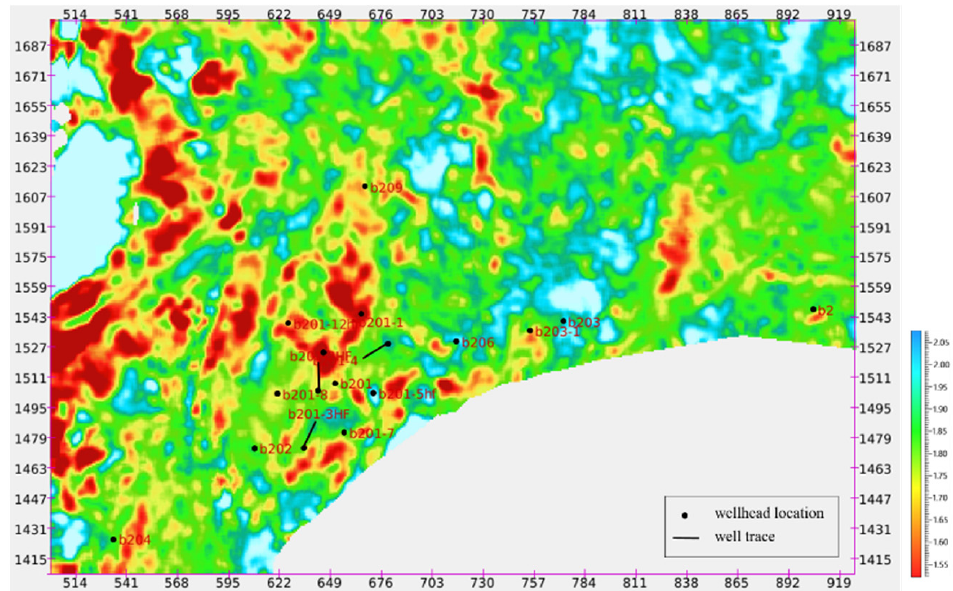
Figure 3. Well placement and Vp/Vs ratio map of working area.